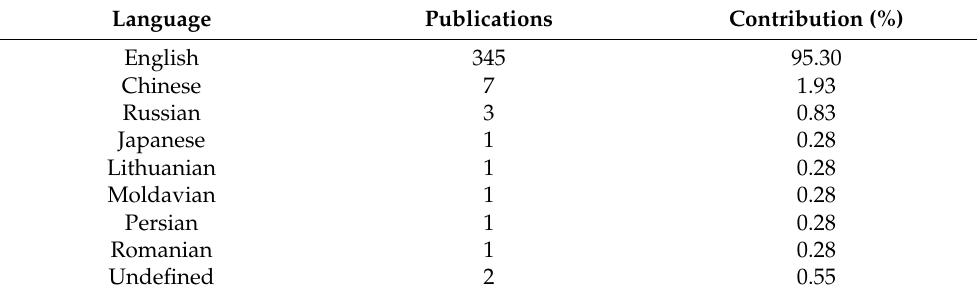
Table 2. The languages employed by the